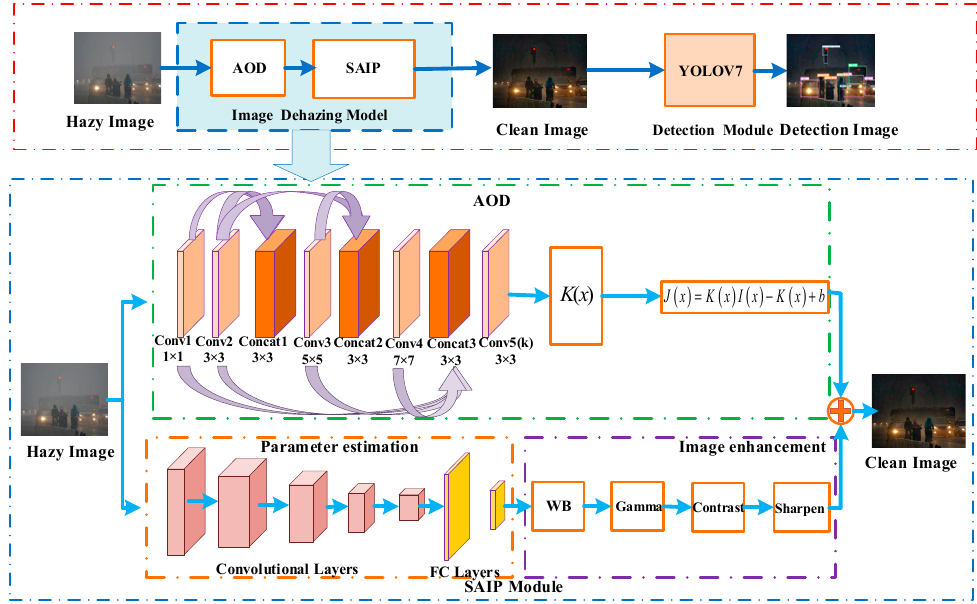
Figure 3. IDOD-YOLOV7 network structure diagram. AOD for image defogging module, SAIP for image enhancement module, and YOLOV7 for object detection module.